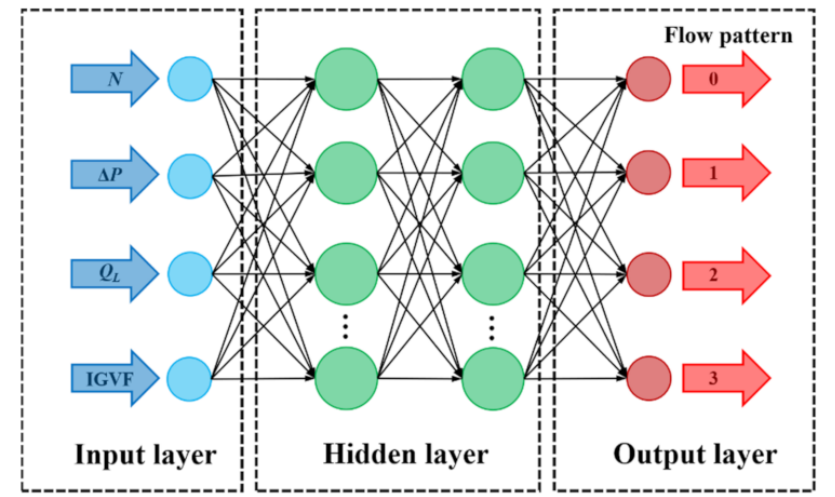
Figure 4. Neural network